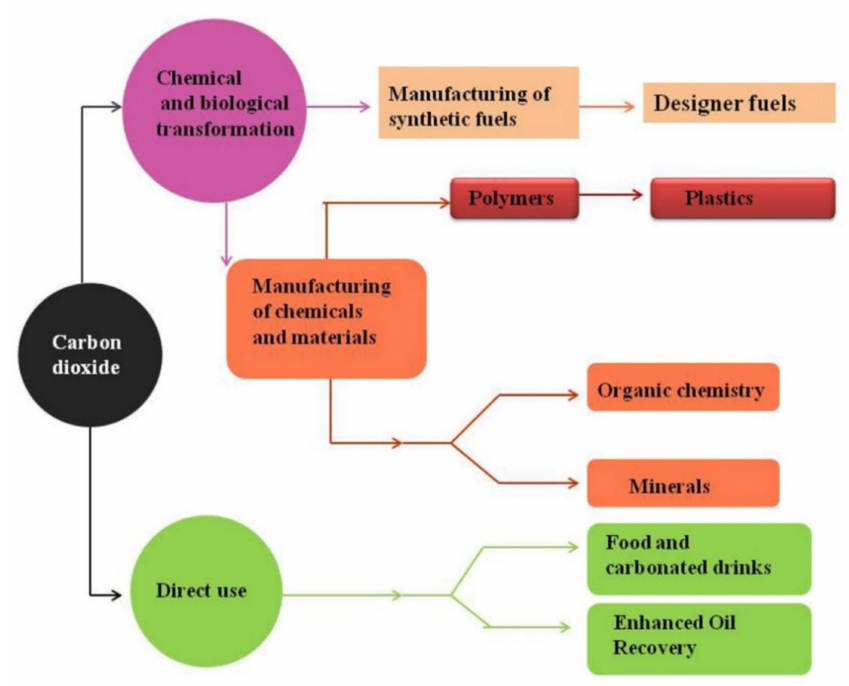
Figure 2. Schematic explanation of photo-induced e − /h + pairs. Reprinted with permission from American Chemical Society, 24 December 2021. Ref. [44].